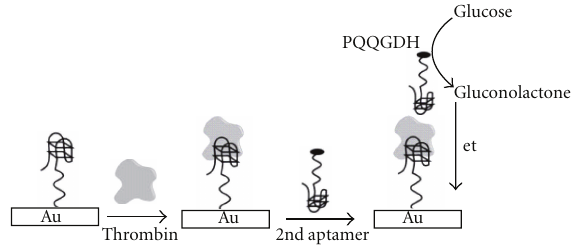
Figure 1: Sandwich assay: the immobilized aptamer captures thrombin and aptamer labeled with pyrroquinoline quinone glu- cose dehydrogenase ((PQQ)GDH) generates electrical current upon glucose